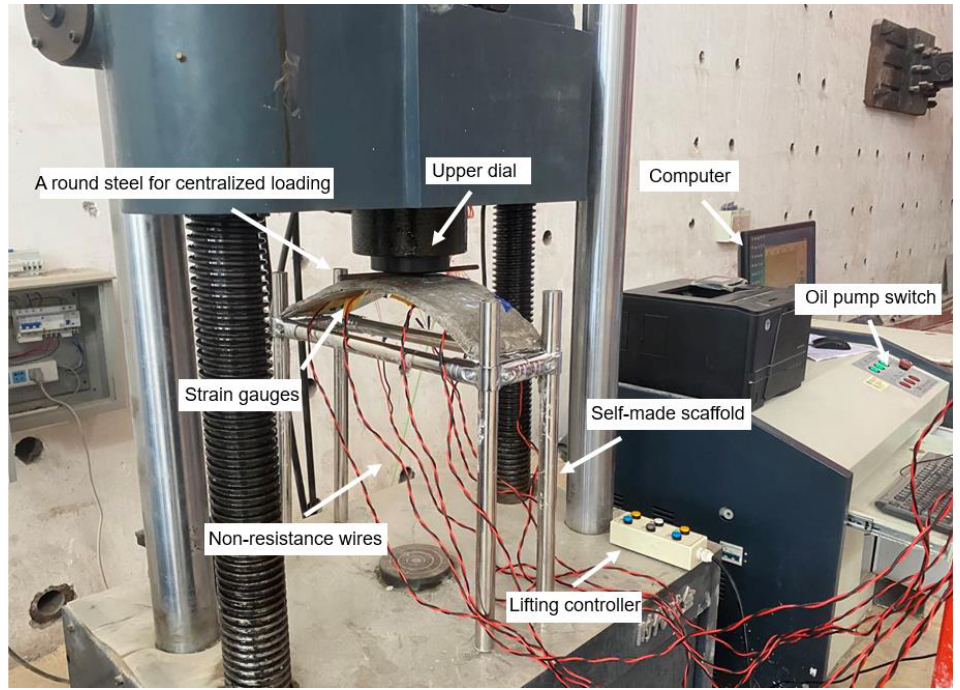
Figure 5. Loading test under line loading.